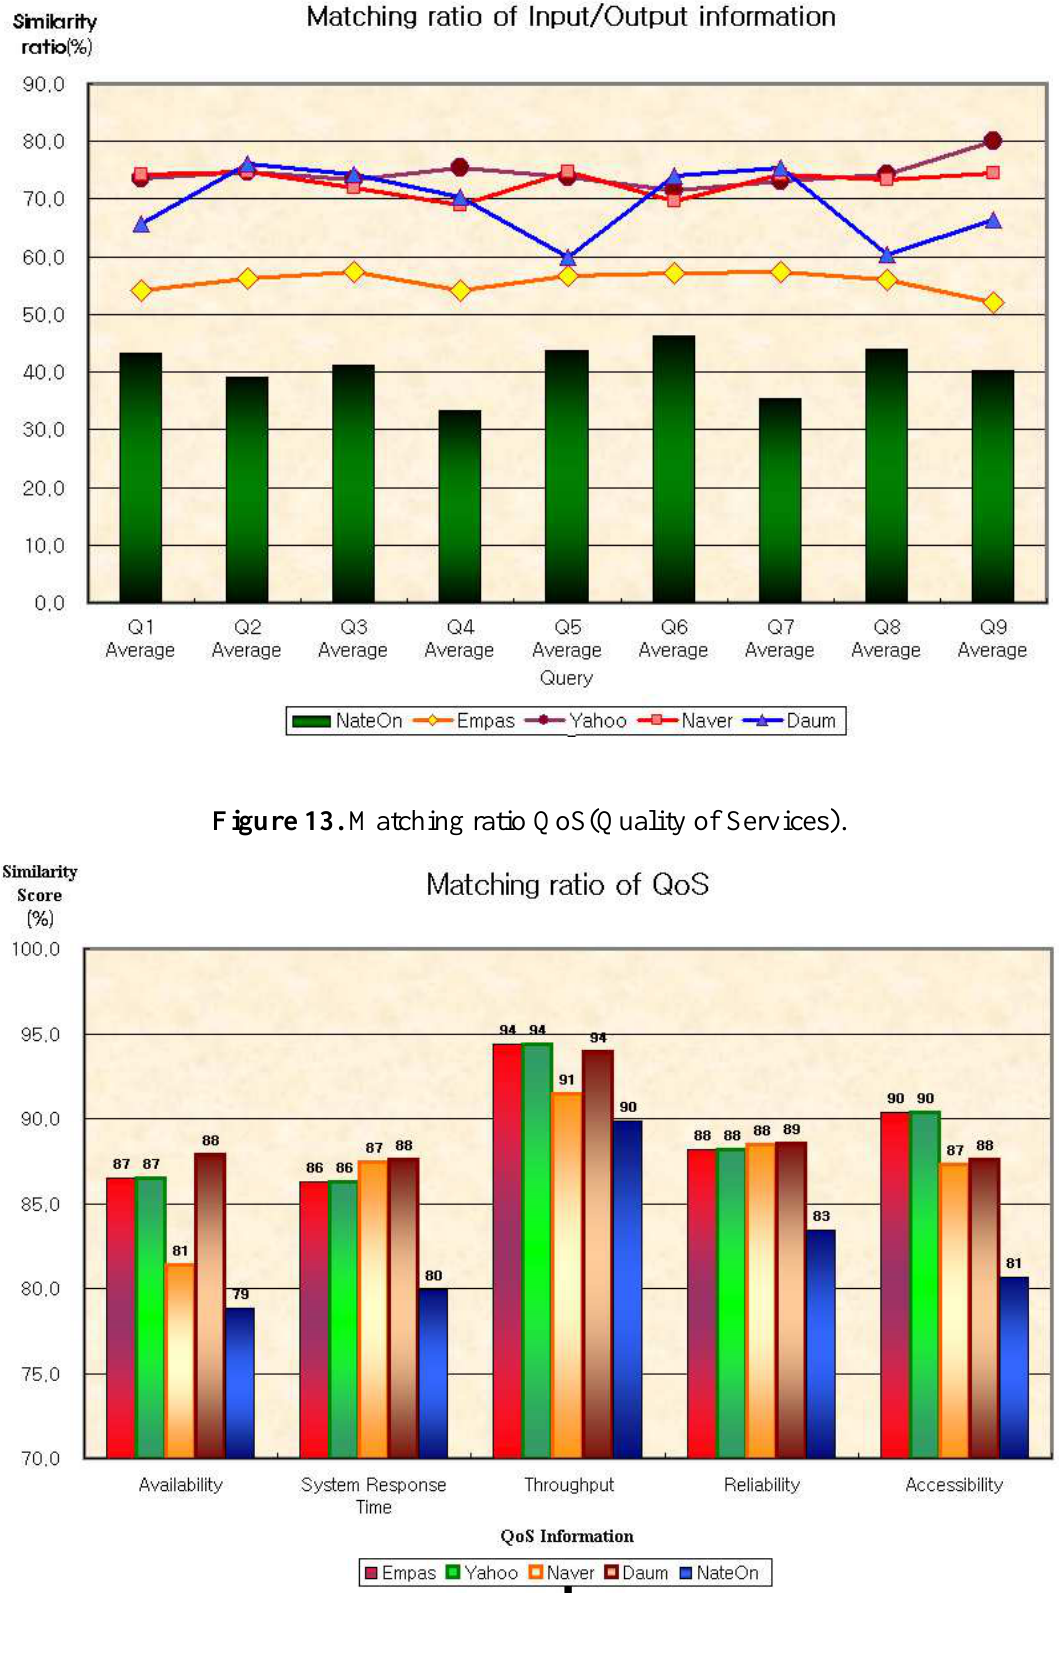
Figure 12. Matching ratio of Input/Output information.